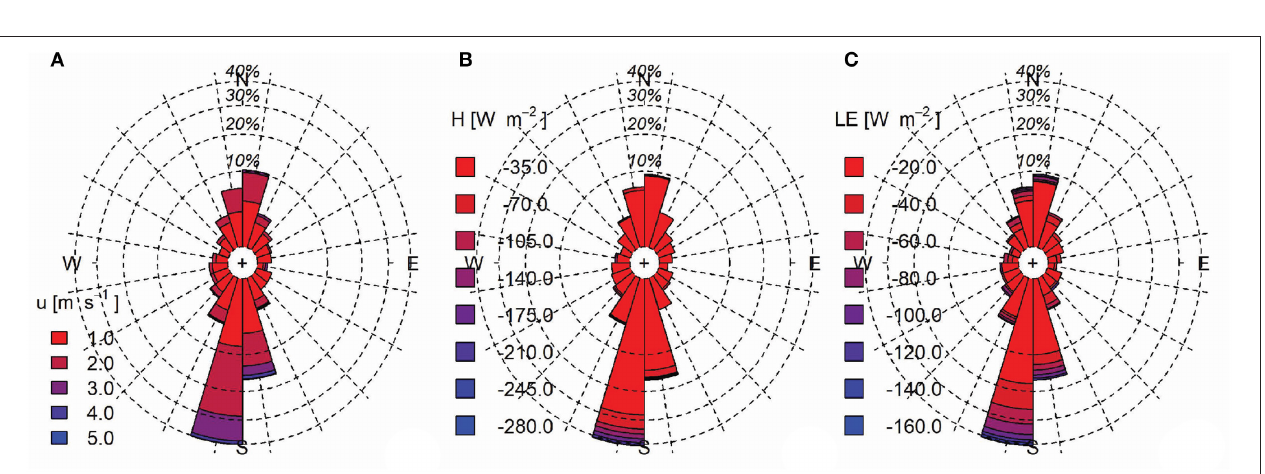
FIGURE 3 | Wind velocities (A) , sensible (B) and latent heat flux (C) relative to wind directions.